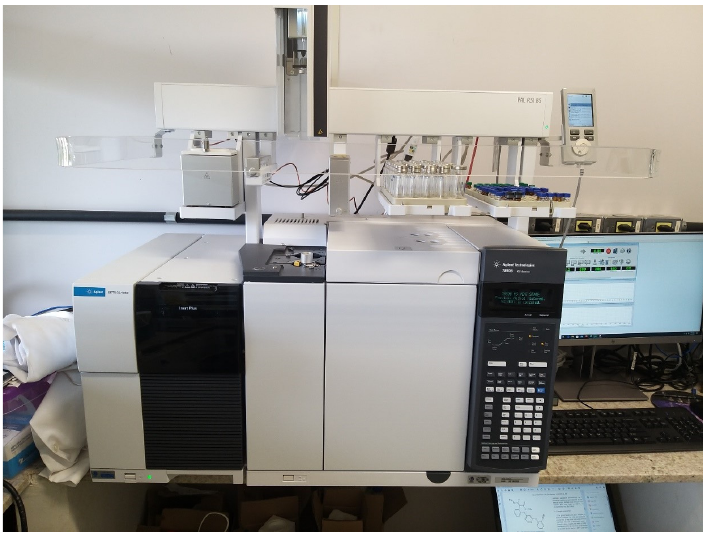
Figure 3. Equipment used to perform gas chromatography coupled to mass spectrometry.